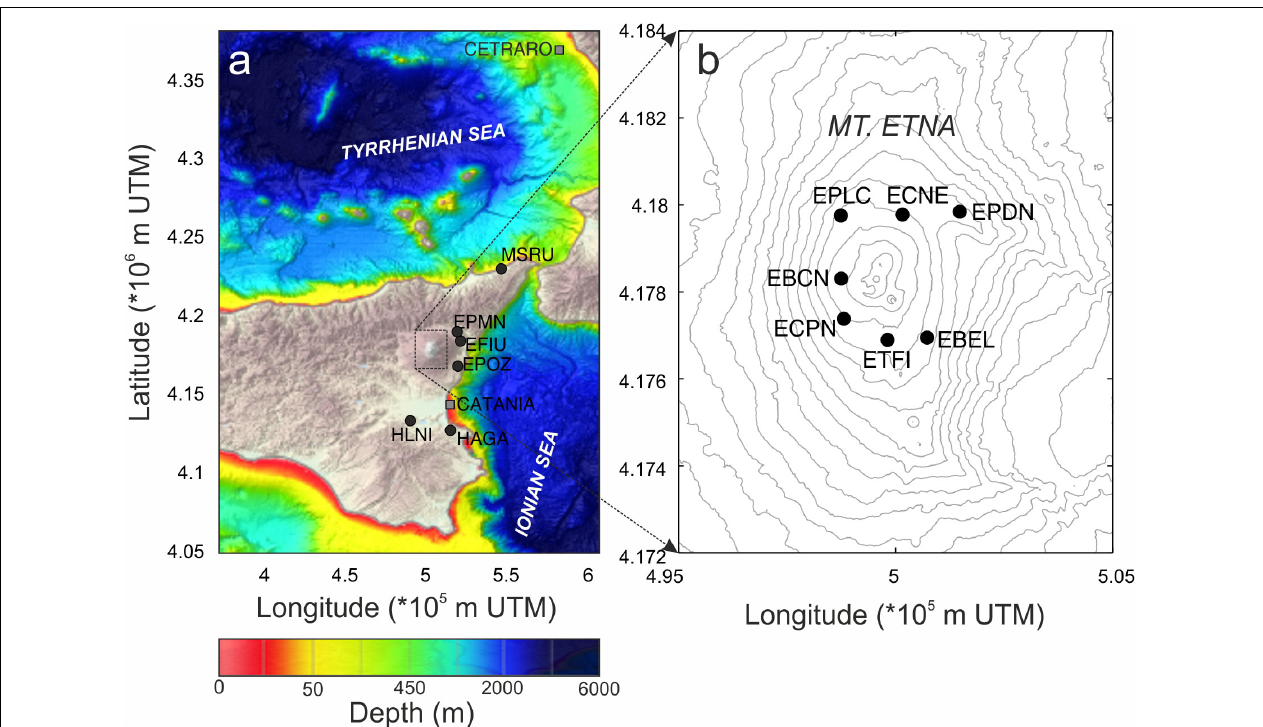
FIGURE 1 | (a) Bathymetric and topographic map (EMODnet Bathymetry Consortium, 2018), with the locations of the seismic stations ( black dots ), used to perform spectral and amplitude analysis of the microseism and to investigate its relationship with significant wave height, recorded by Catania and Cetraro buoy stations ( gray squares ). (b) Digital elevation model of Mt. Etna, with the locations of the seismic stations ( black dots ), used to perform array